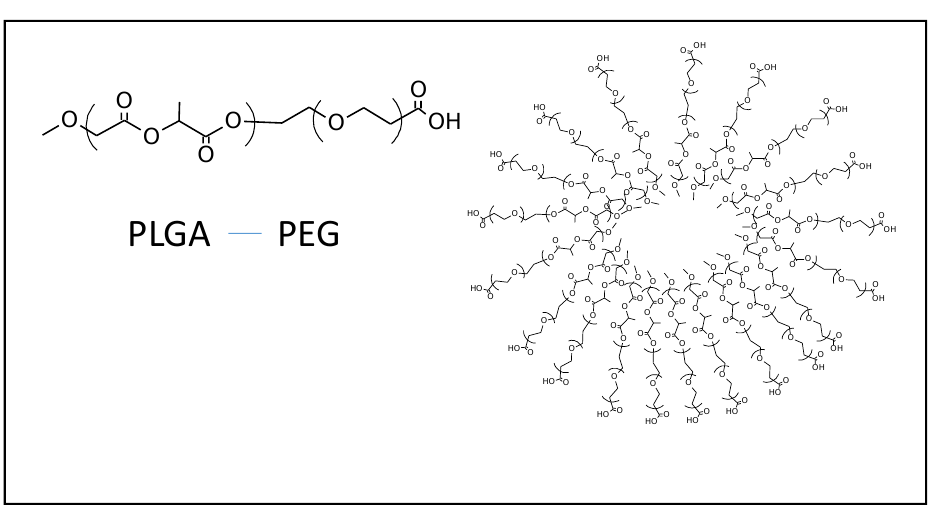
Figure 2. Schematic representation of polymeric nanoparticle (right). Chemical structure of polymer based on the combination of PEG and PLGA (left) used for the formation of the nanoparticle.